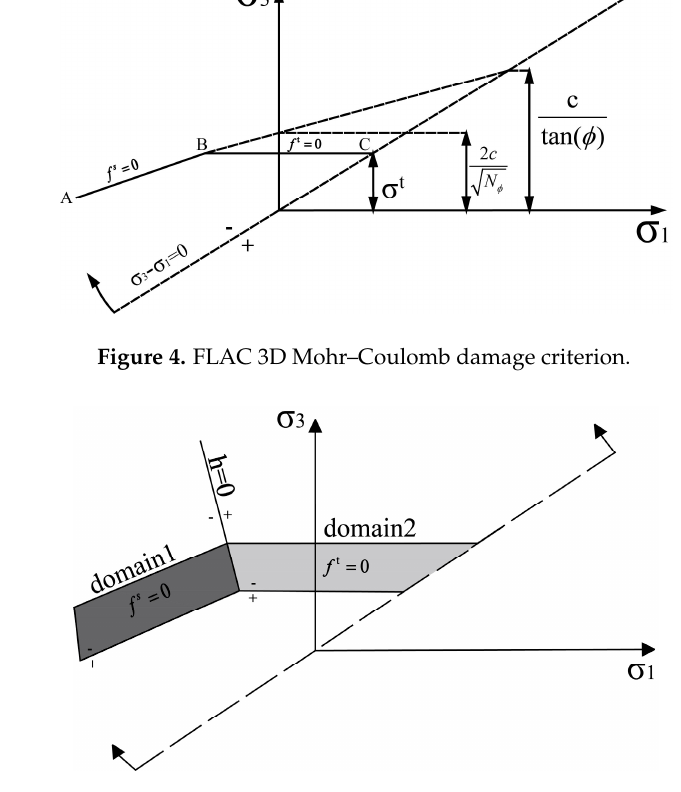
Figure 5. Mohr–Coulomb model flow rule.